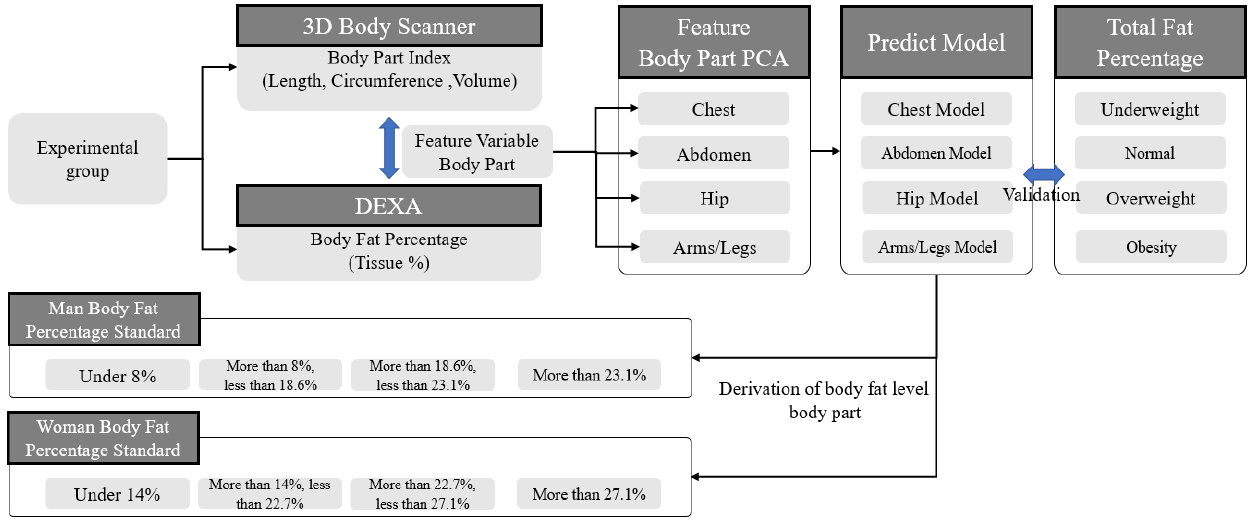
Figure 4. Entire process used in the obesity measurement model.